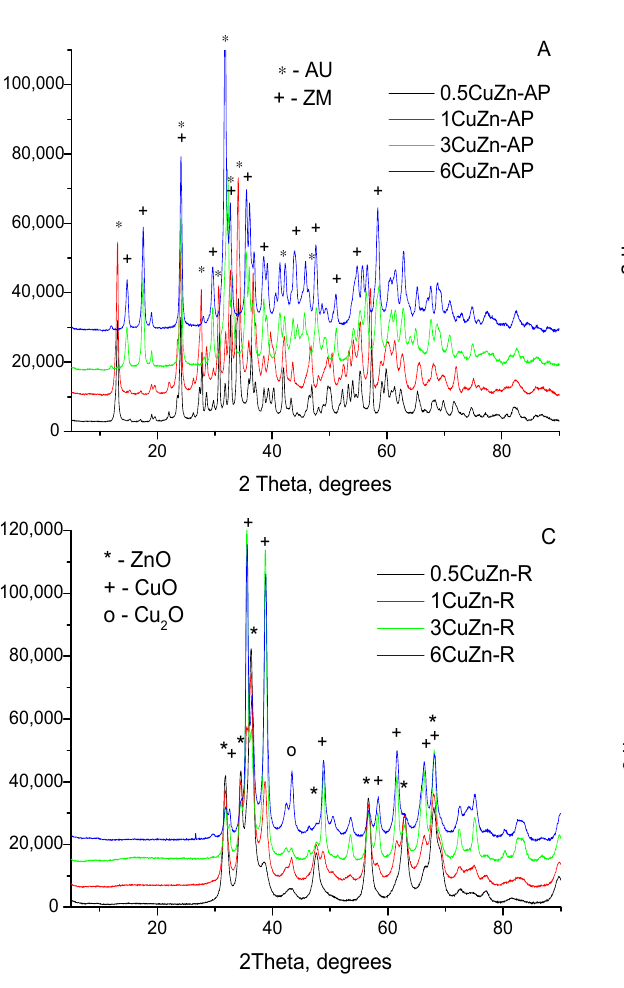
Figure 1. XRD patterns of the as-prepared CuZn precursors ( A ), calcined mixed oxides ( B ), samples reduced by a standard method ( C ), samples reduced and treated with MeHe ( D ).